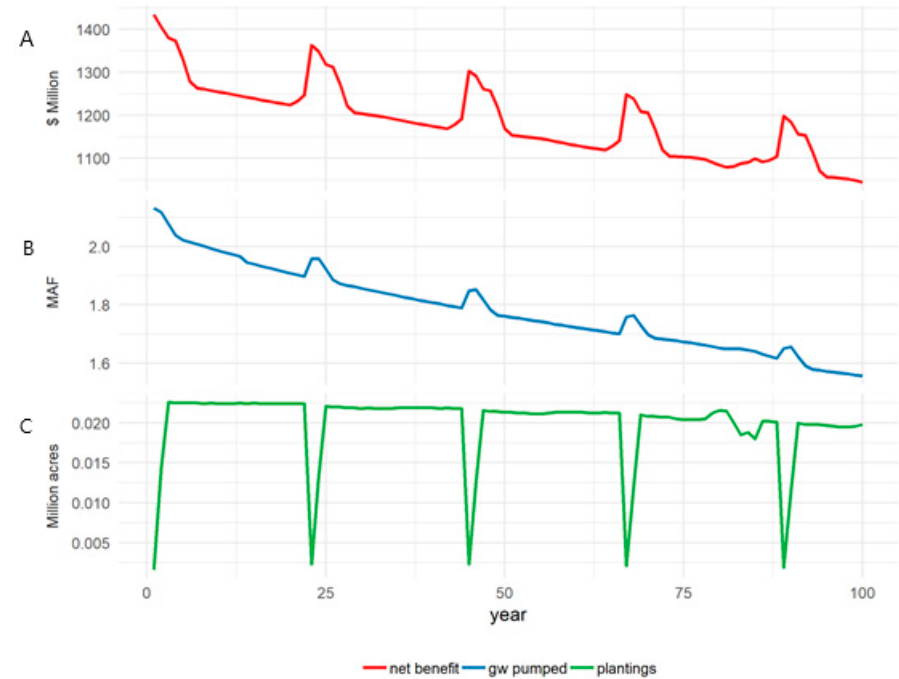
Figure 2. Baseline scenario. ( A ) annual net benefits, ( B ) groundwater pumped, and ( C ) perennial plantings. There are no plantings or removals of perennials in the first year, and subsequent plantings and removals (not shown) are in balance until year 23 when both fall to almost zero again. As perennials are replanted, there is a smoothing out of the land distribution across age classes such that, eventually, the model, ceteris paribus, will converge to com- pletely smooth planting and removal time series. This finding is consistent with [31] and [12], although it should be noted that the smoothing in those papers follows from the use of a non-linear utility function, whereas here, it results from the model’s calibration. To further demonstrate the behavior of the model, Figure 3 shows the time series of the aquifer level and land use by crop type. Consistent with Figure 2, groundwater pump- ing steadily draws down the aquifer, resulting in higher pumping costs over time. Those costs then translate to a decrease in the area devoted to the more water-intensive perennial crop in favor of annual crops with no land left fallow in any time period.